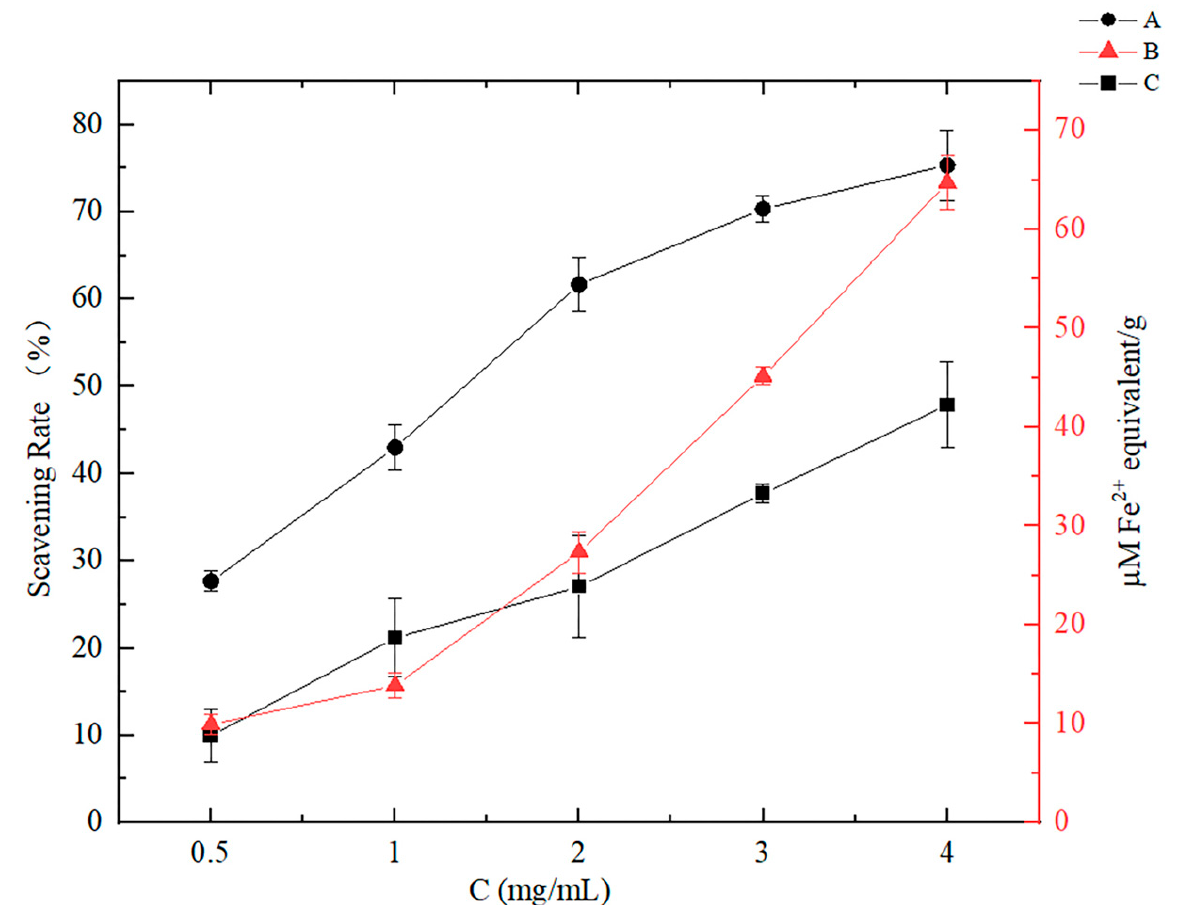
Figure 2. Antioxidant activities of the CNPs in vitro under different concentration conditions. A: Measured using ABTS method, expressed as free radical scavenging activity (%). B: Measured using FRAP analysis, expressed as Fe 2+ equivalent. C: Measured using DPPH method, expressed as free radical scavenging activity (%).